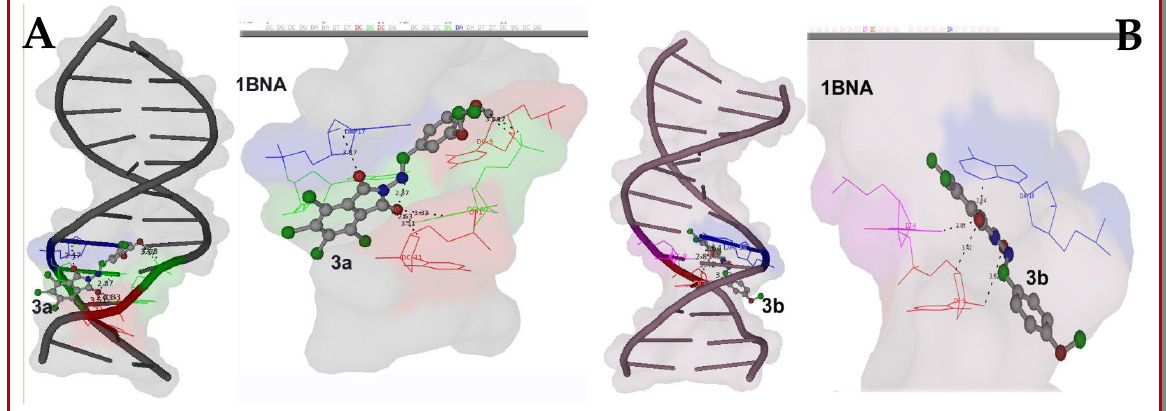
Figure 4: Molecular docked model of the most favorable binding site of compounds ( 3a and 3b) with DNA dodecamer duplex of sequence d(CGCGAATTCGCG) 2 (PDB ID: